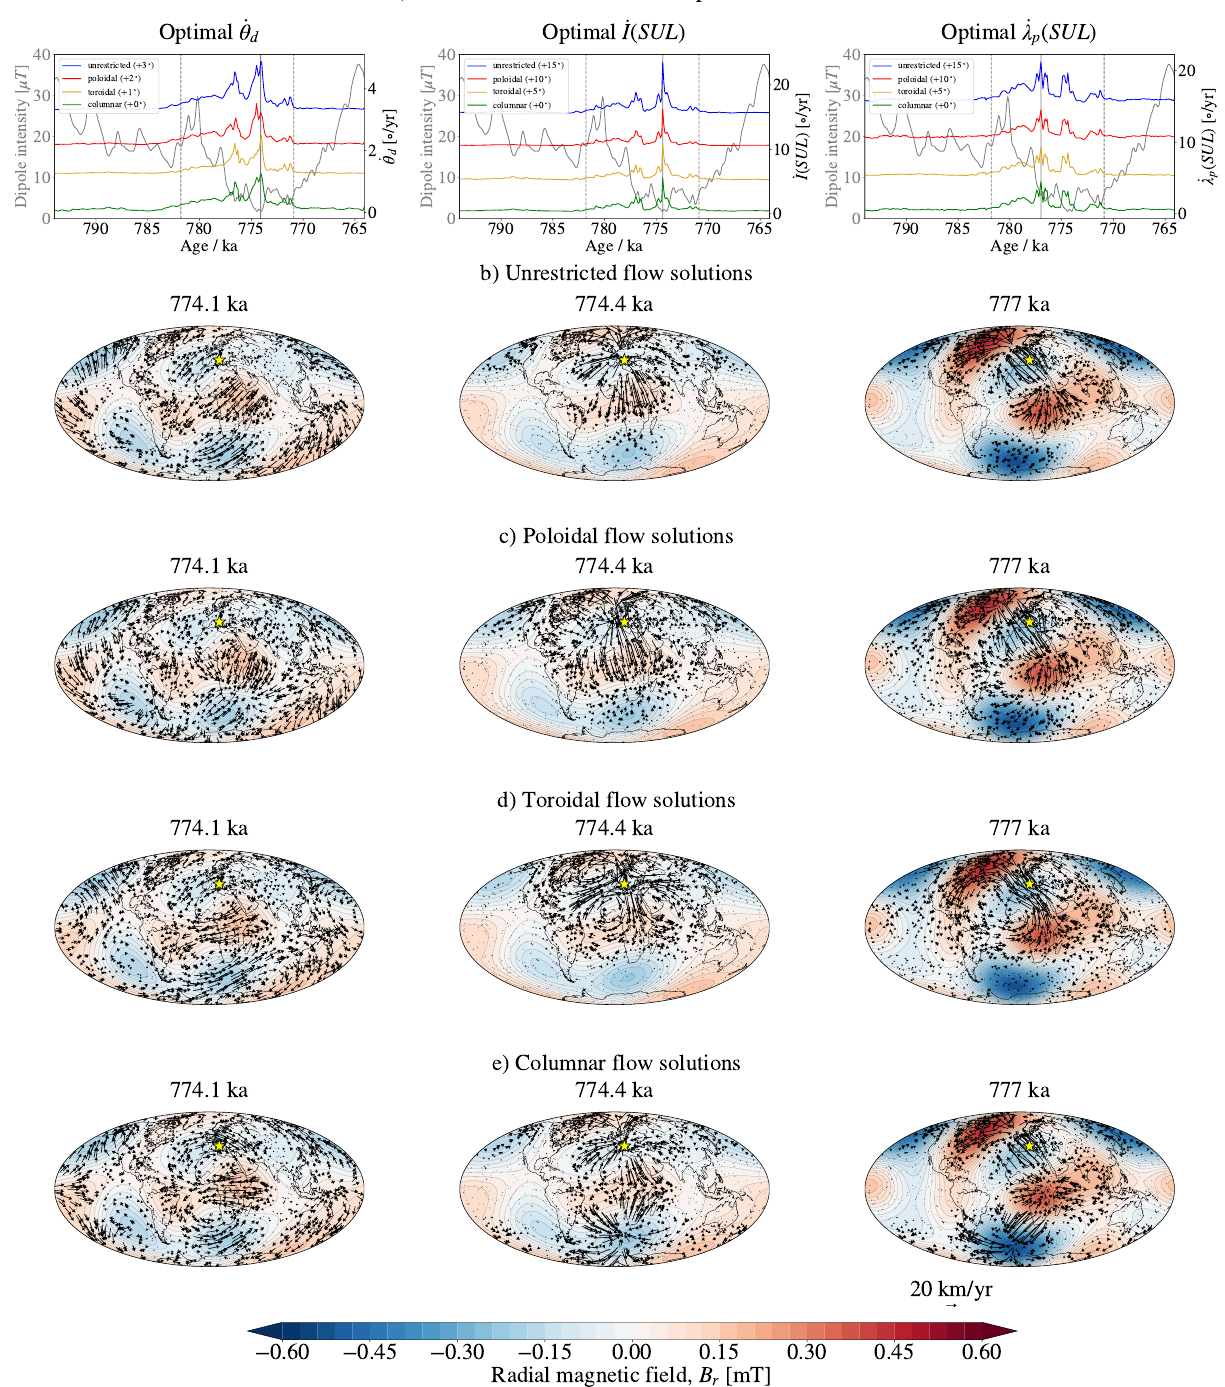
Figure A2. Instantaneous optimal solutions calculated with the IMMAB4 field model as the background and for T 0 = 13 km/y. ( a ) Time series of the instantaneous optimal rate of change of dipole tilt, inclination at Sulmona and VGP latitude. The coloured curves (indicating solutions for different flow geometries) are offset by the value indicated in the figure for the ease of inspection. The grey curves indicate the intensity of the dipole field as predicted by the IMMAB4 model, for comparison, and the vertical dashed lines represent the boundaries of the reversal period. The vertical continuous lines indicate the instant for which the maximal variation is produced by the unrestricted flow solution (as reported in Figure 7). These epochs are, respectively, 774.1 ka (left panels), 774.4 ka (middle panels) and 777.0 ka (right panels). Maps of the radial background field and optimal flows are shown for these epochs and for unrestricted ( b ), poloidal ( c ), toroidal ( d ) and columnar ( e )